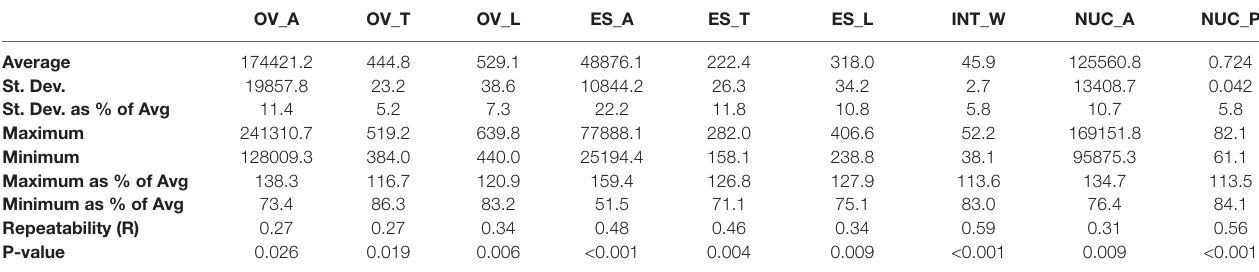
TaBLe 1 | Summary of natural variation, repeatability, and genotypic variance in nine mature ovule traits in 127 genotypes of two-row spring barley. OV_A, ovule area (µm 2 ); OV_T, ovule transverse width (µm); OV_L, ovule longitudinal height (µm); ES_A, embryo sac area (µm 2 ); ES_T, embryo sac transverse width (µm); ES_L, embryo sac longitudinal height (µm); INT_W, integument width (µm); NUC_A, nucellus area (µm 2 ); NUC_P, nucellus proportion